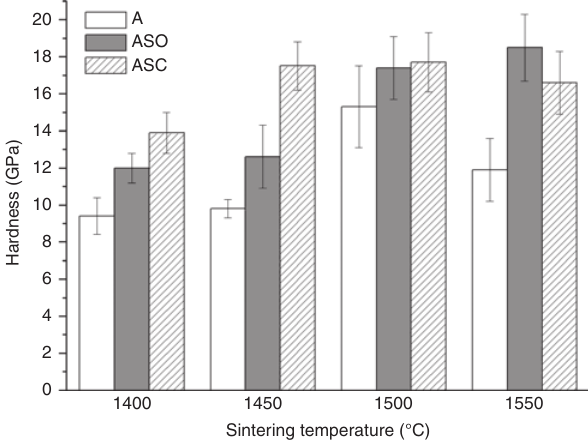
Figure 5: Graph of hardness versus sintering temperature.